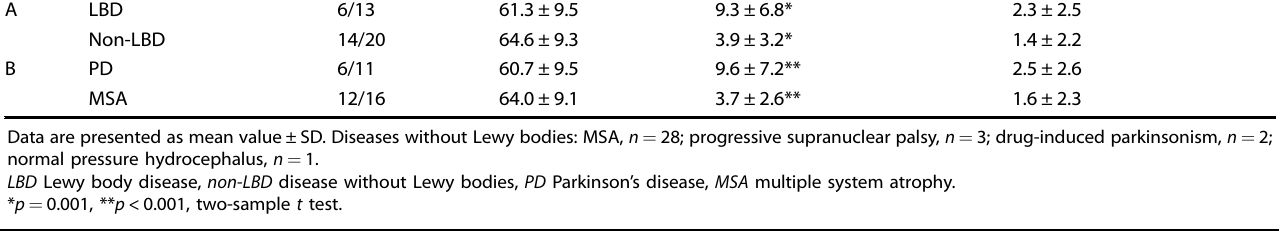
Table 1. Demographic characteristics of patient groups. Analysis Patient group (clinical